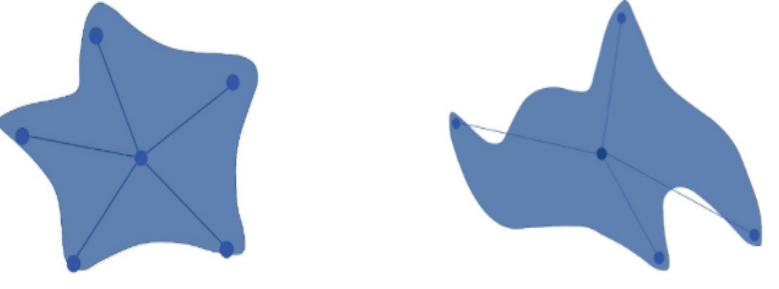
Figure 4. This figure defines the difference between star-convex objects and non-star-convex